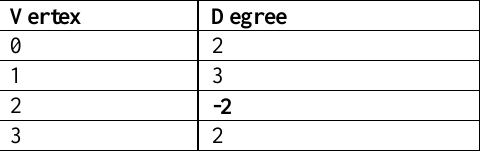
Table 5: Updated degrees of the vertices in the graph after assigning the colour to vertex 2.